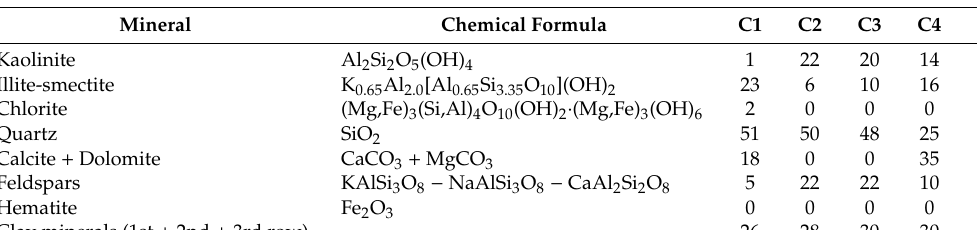
Table 3. Phase composition of the clays (%).